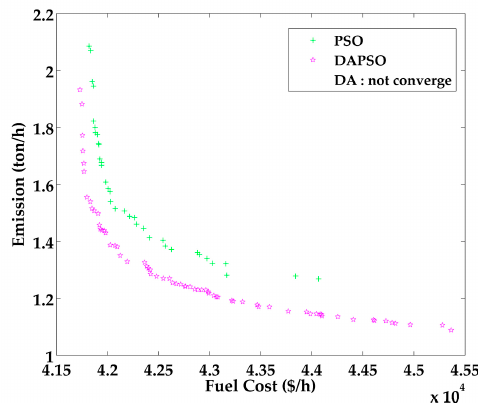
Figure 6. Two-dimensional Pareto fronts when considering fuel cost and emissions as part of the objective function for the IEEE 57-bus system. Energies 2018 , 11 ,